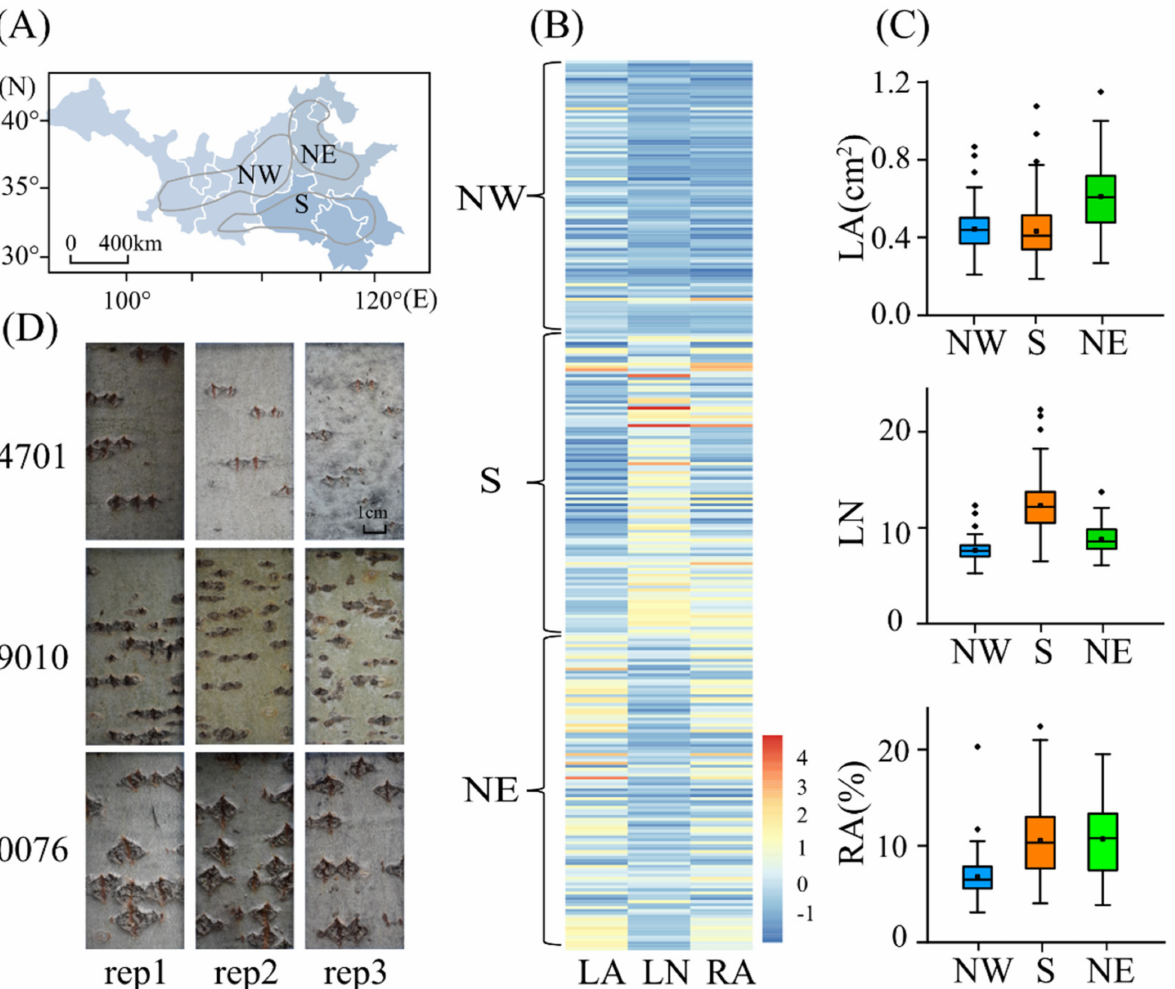
Figure 1. Phenotypic variation in lenticel traits in a natural population of Populus tomentosa . ( A ) Map of climatic region- alization of the P. tomentosa population. Grey blocks indicate administrative divisions among provinces of China. Black lines indicate the three climate regions, based on Huang (1992). Northwest (NW), Northeast (NE), and South (S) represent the northwest, northeast, and southern climate regions, respectively. ( B ) Heatmap visualization of the association of three lenticel traits in the population. ( C ) Box plot of the three lenticel traits. ( D ) Lenticel phenotypic differences among three representative individuals (4701, 9010, and 0076) from the three climate regions. Rep1–3 represent three clones of the same genotype. Bars = 1